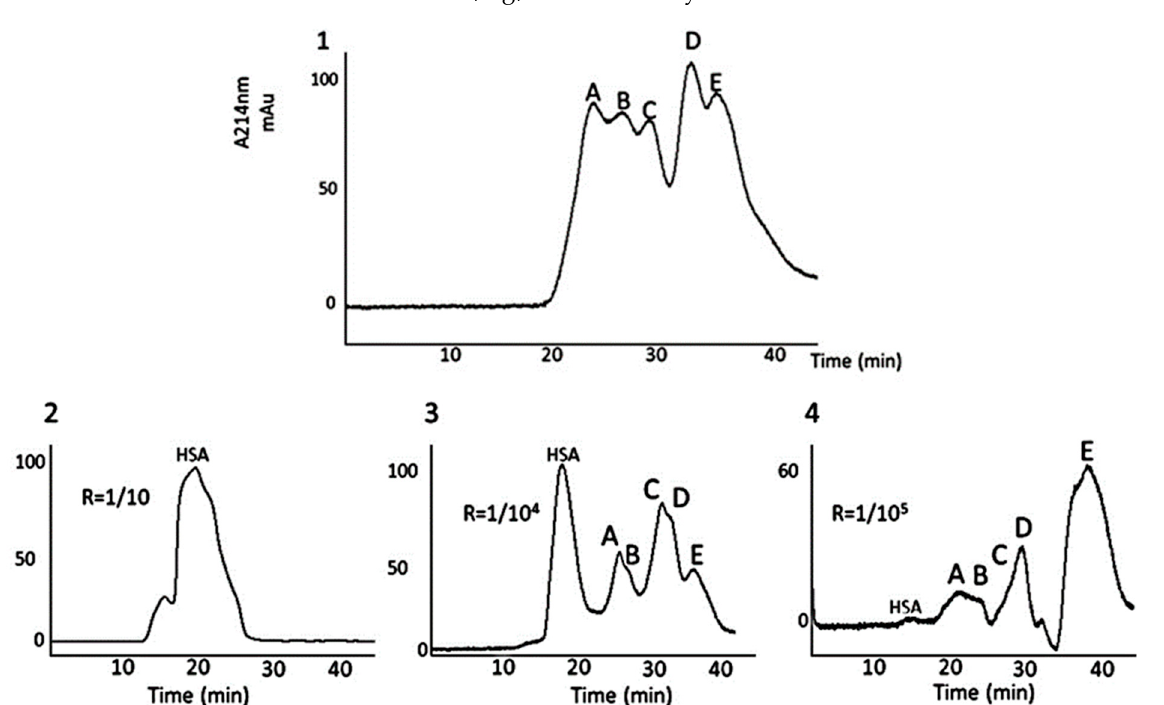
Figure 2. Gel filtration HPLC of purified and oxidized VS-I samples to evaluate the impact of different concentrations of therapeutic human serum albumin (HSA) on multimers of VS-I. For the four graphs, the X-axis corresponds to the elution time (expressed in min), which is linearly related to the molecular weight of the components included in the peaks. The Y-axis corresponds to absorbance expressed in milliUnits of absorbance. Whether in vitro or in vivo, the oxidation of VS-I leads to multimerization, as shown on the first chromatogram (upper graph, numbered 1). The monomeric form of the peptide corresponds to peak E, while peaks A-D correspond to VS-I multimers. When adding fresh, non-oxidized therapeutic HSA at a molar albumin/VS-I ratio (R) from 1/10 to 1/10 5 (as shown on chromatograms 2–4), the release of the monomeric VS-I increases (see changes in the amplitude of peak E). This counterintuitive result explains the possible release of monomers of VS-I with the restoration of its anti-microbial properties